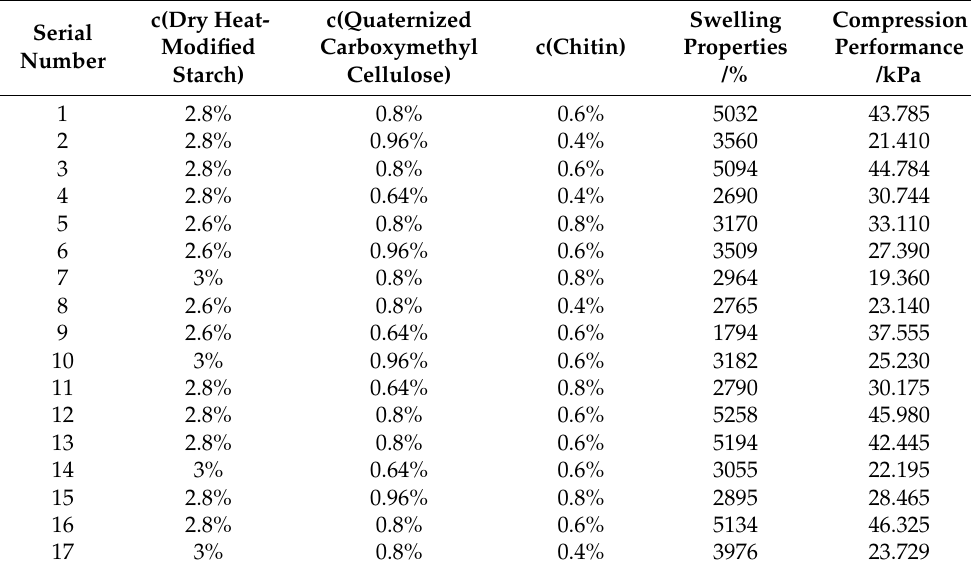
Table 1. Design and results of the central combination